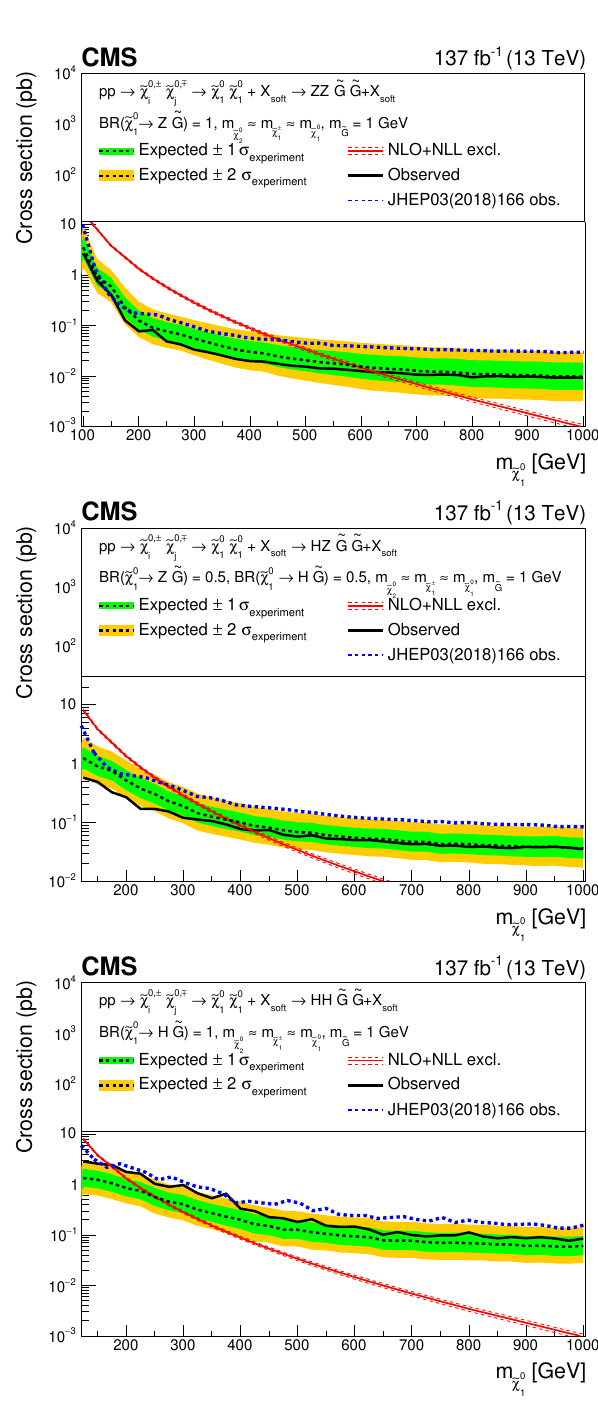
pair production, with ZZ -mediated decays Figure 21 . Interpretation of the results for effective e c 0 1 (upper), HZ -mediated decays (middle), and HH -mediated decays (lower). The median expected upper limits (black line) are shown along with the ± 1 σ ( 0 . 16 and 0 . 84 quantiles, green) and ± 2 σ ( 0 . 05 and 0 . 95 quantiles, yellow) bands. The predicted production cross sections computed at NLO plus NLL are shown in red and the observed exclusion limits obtained in the CMS analysis using 2016 data [20] are shown in